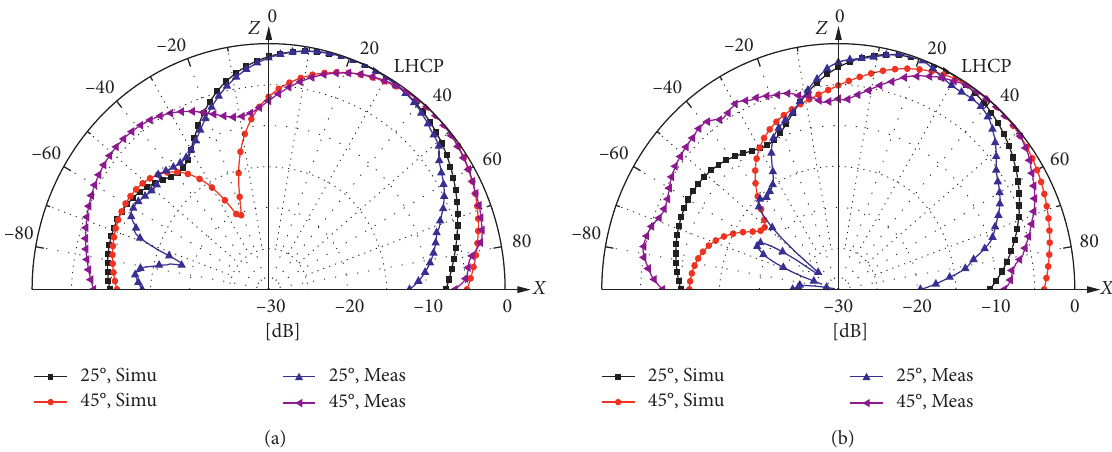
Figure 19: The normalized radiation pattern measured results of different ports of the RPA prototype. (a) Port 1. (b) Port